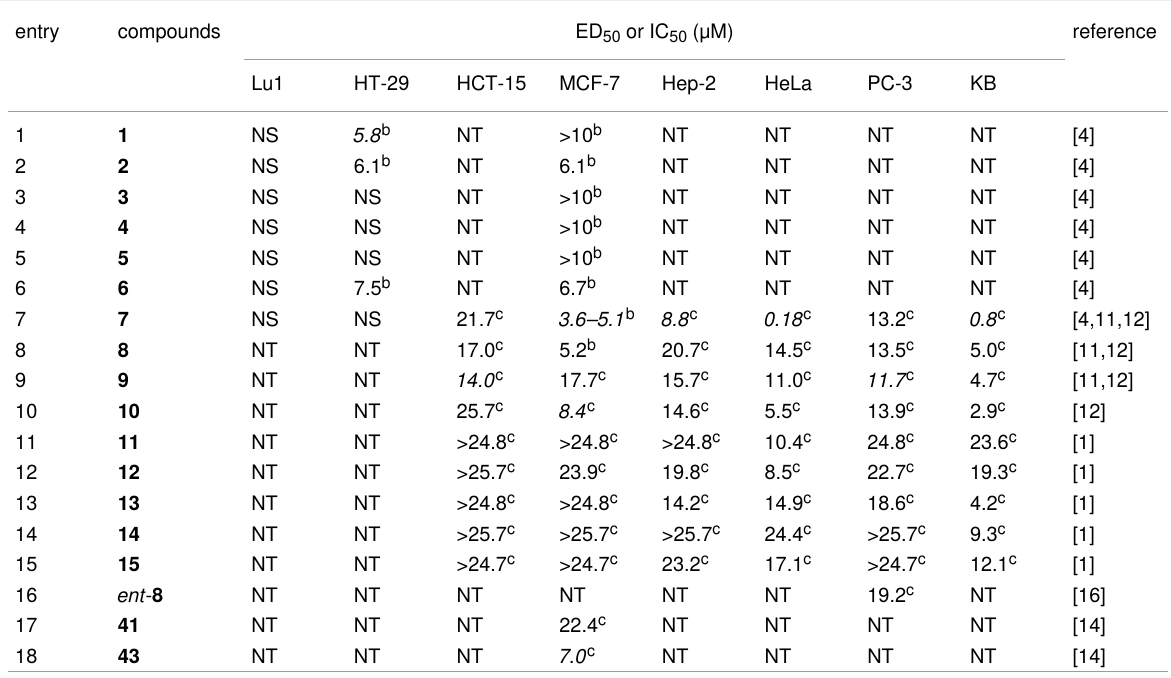
Table 1: Cytotoxicity data of brevipolides and their derivatives against selected cancer cell lines.